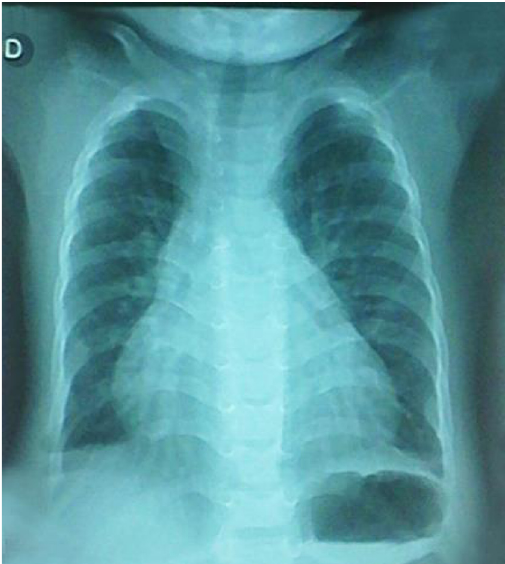
Fig. 4. X-ray of the thorax showing narrow chest.